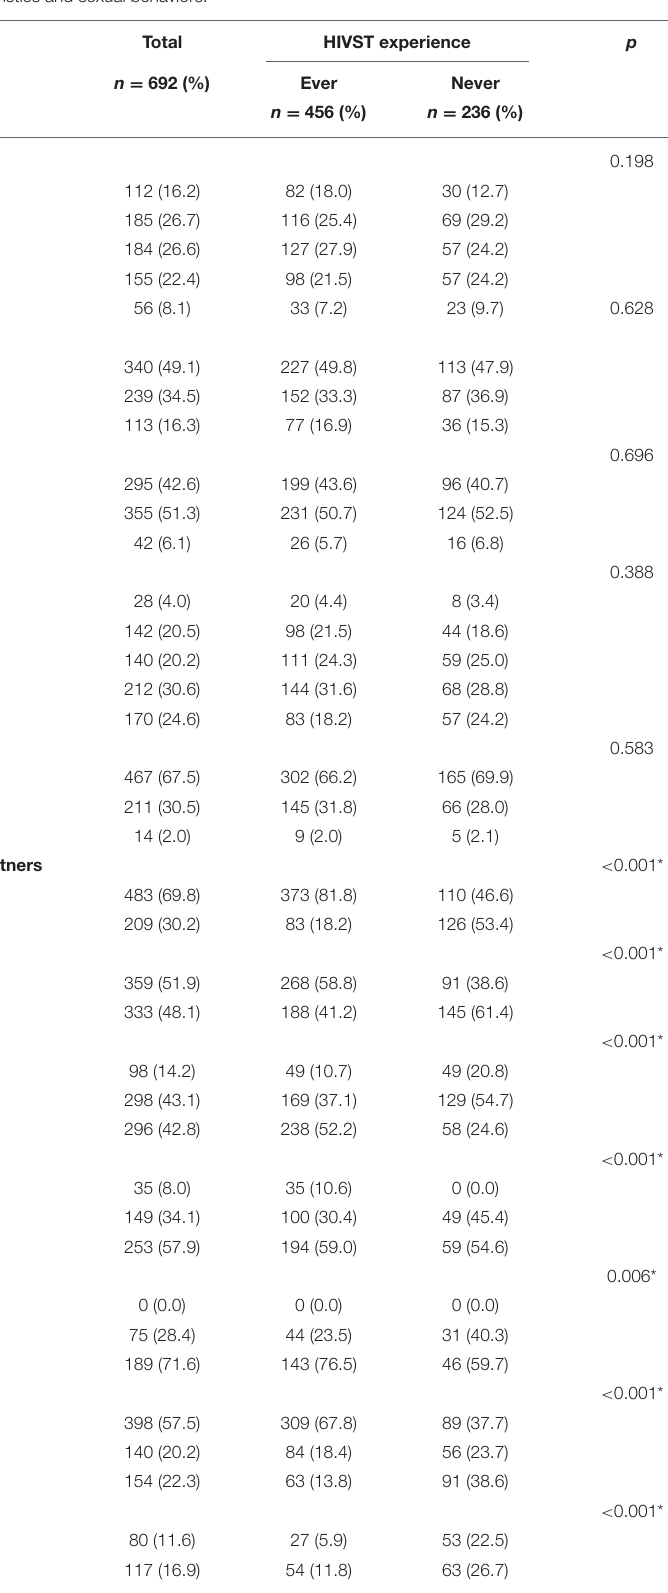
TABLE 1 | Descriptive summary of participants’ socio demographic characteristics and sexual